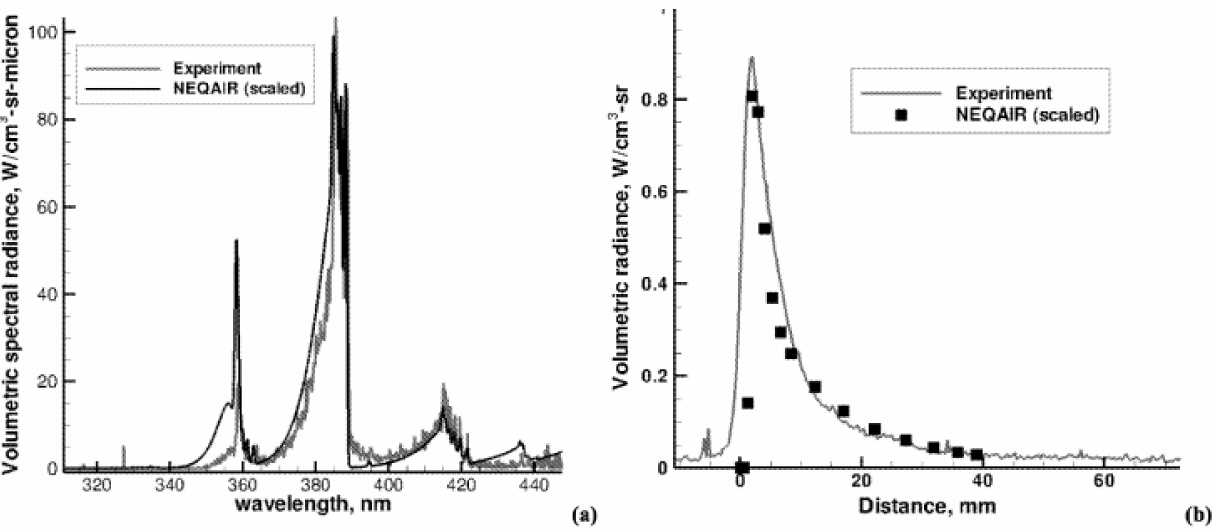
Figure 36. Comparison of NEQAIR calculations and X2 test data: ( a ) volumetric spectral radiance between 310 and 450 nm; ( b ) volumetric radiance along stagnation line (from